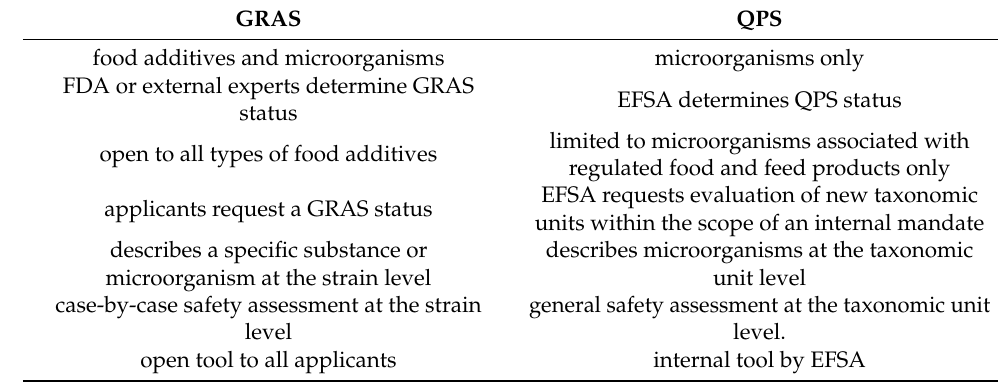
Table 3. Differences between the GRAS guidelines (FDA, USA) and the QPS